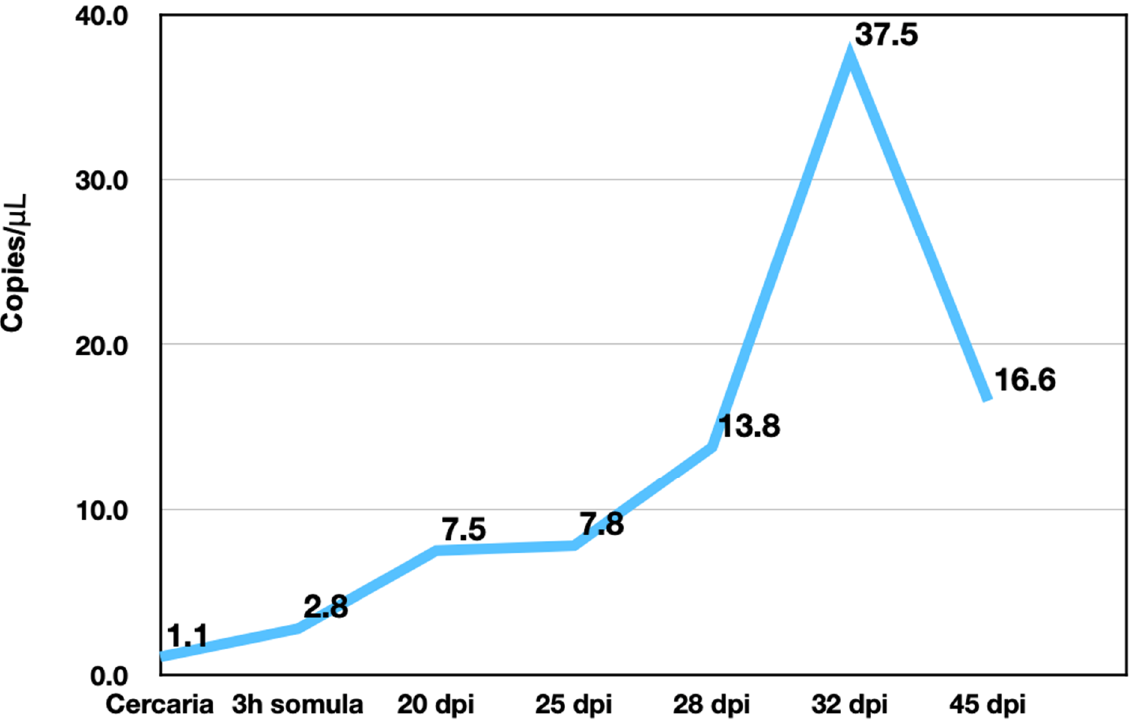
Figure 5. Concentration (copies/µL) of SmSULT expressed in male infections throughout the life stages.